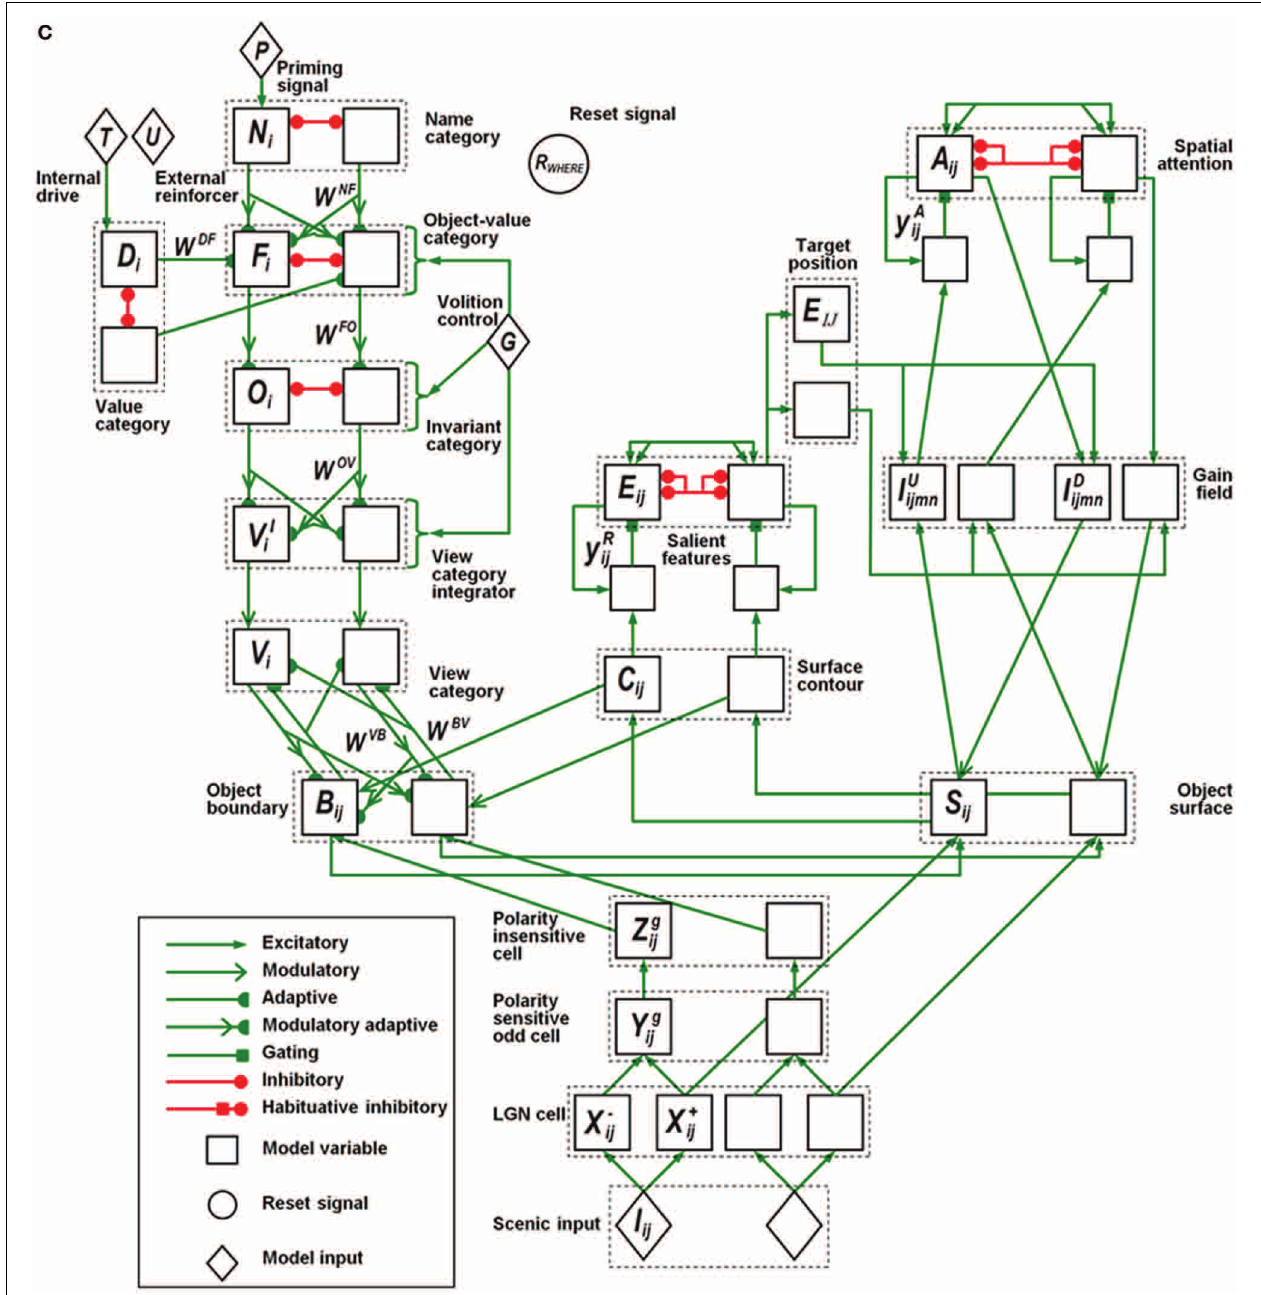
FIGURE 7 | Model variables and their computational relations. (A) Category learning. (B) Direct pathway of top-down primed search. (C) Indirect pathway of top-down primed search. The dashed boxes correspond to the layers of the box diagram in Figure 1 . Each layer has two neurons indicating